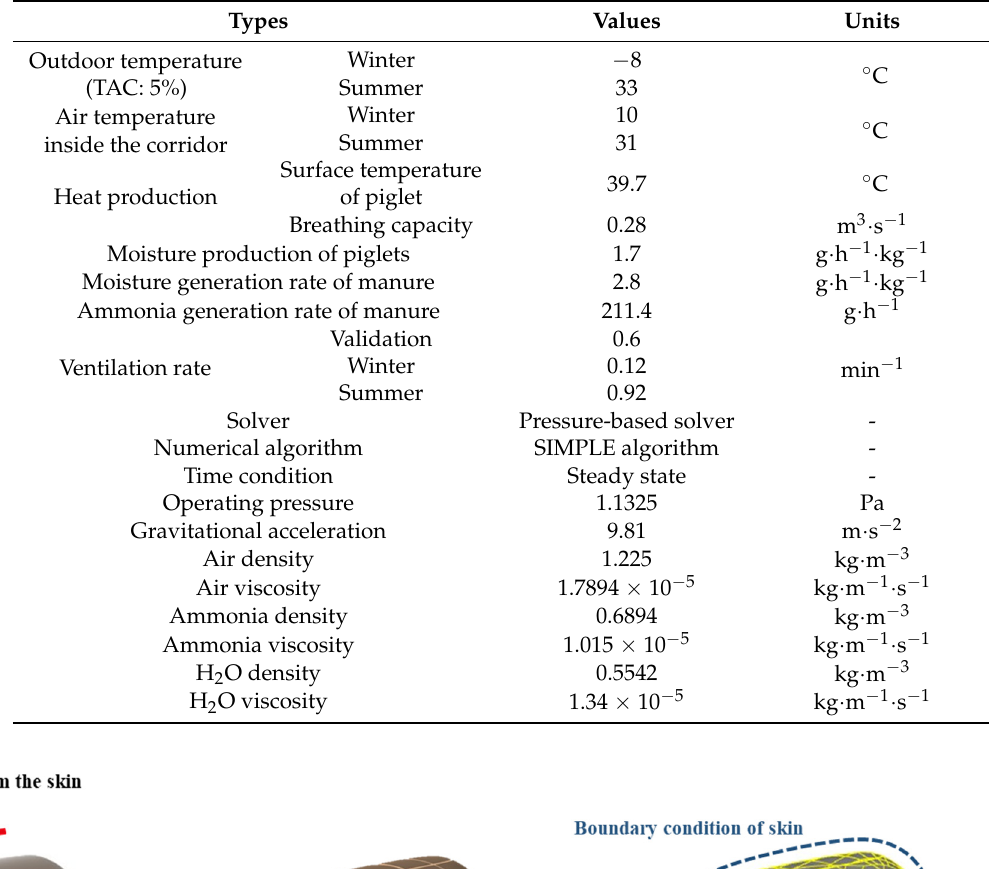
Table 2. Boundary conditions of CFD simulation.